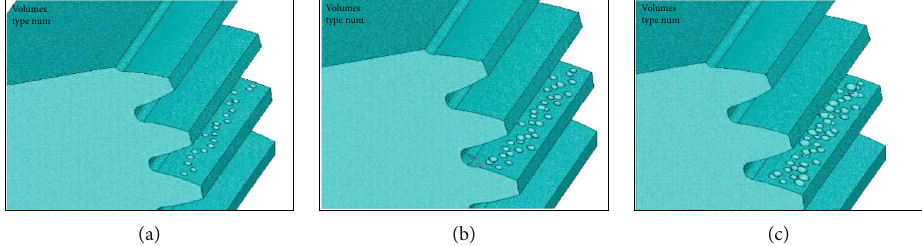
Figure 5: Di ff erent pitting gear FEM models. (a) Degree 1 pitting gear model. (b) Degree 2 pitting gear model. (c) Degree 3 pitting gear model.